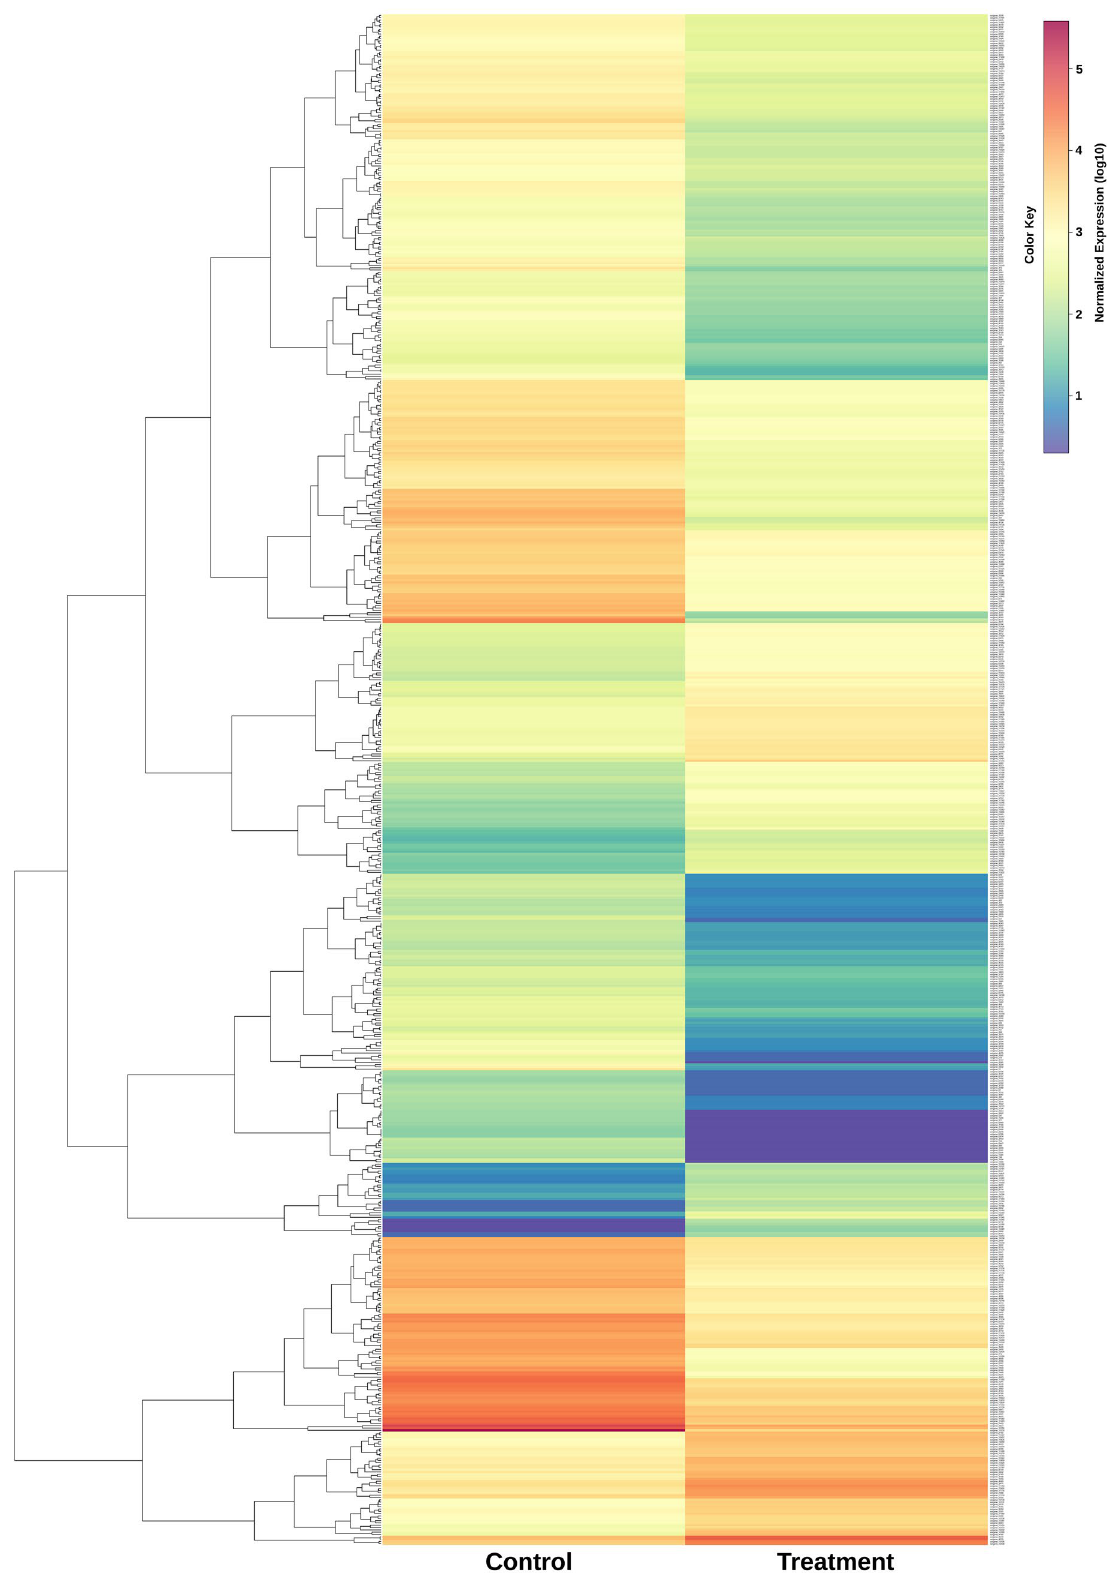
Figure 4. Heatmap and hierarchical cluster analysis of differentially expressed genes based on the expression pattern of 661 DEGs derived from the control (0 M NaCl) and salt-treated (0.5 M NaCl) P. indica 14 days after treatment. The color scale represents the expression of DEGs in terms of normalized expression of DEGs between control and salt-treated samples. Tool: gplots package in R